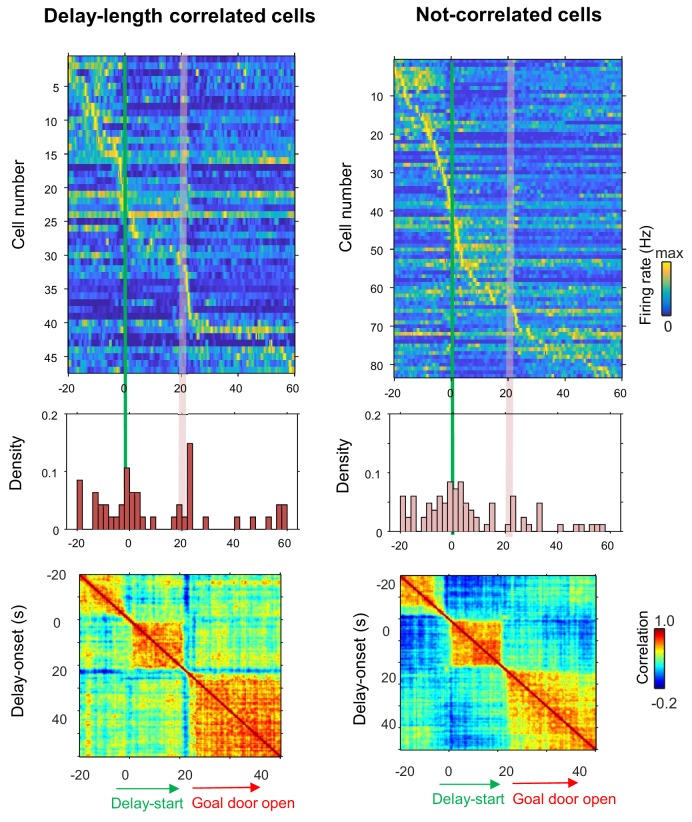
Population coding of long delay in the delay-length-correlated and non-correlated CA1 cells.Temporal patterns of firing rates in CA1 delay-length-correlated and non-correlated cells during delay. Top, color-coded temporal firing patterns. Neurons were ordered by the time of their peak firing rates. Middle, temporal distribution of the peak firing rates of the neurons. Green lines indicate delay-onset. Pale red lines indicate expected delay-offset. Bottom, correlation matrix of population vectors as a function of time for CA1 delay-active and delay-suppressed cells.